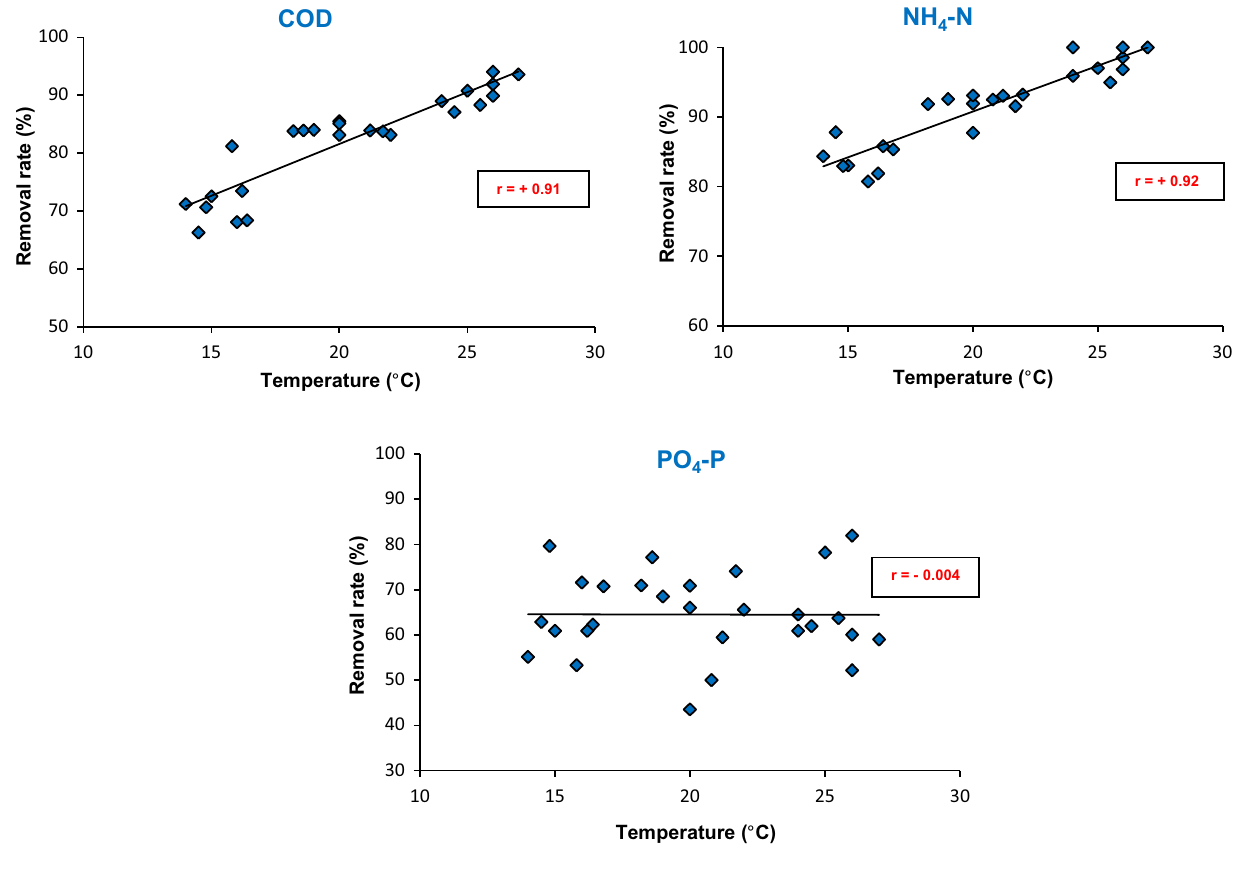
Fig. 4 Scatter plots of COD, NH 4 -N and PO 4 -P against